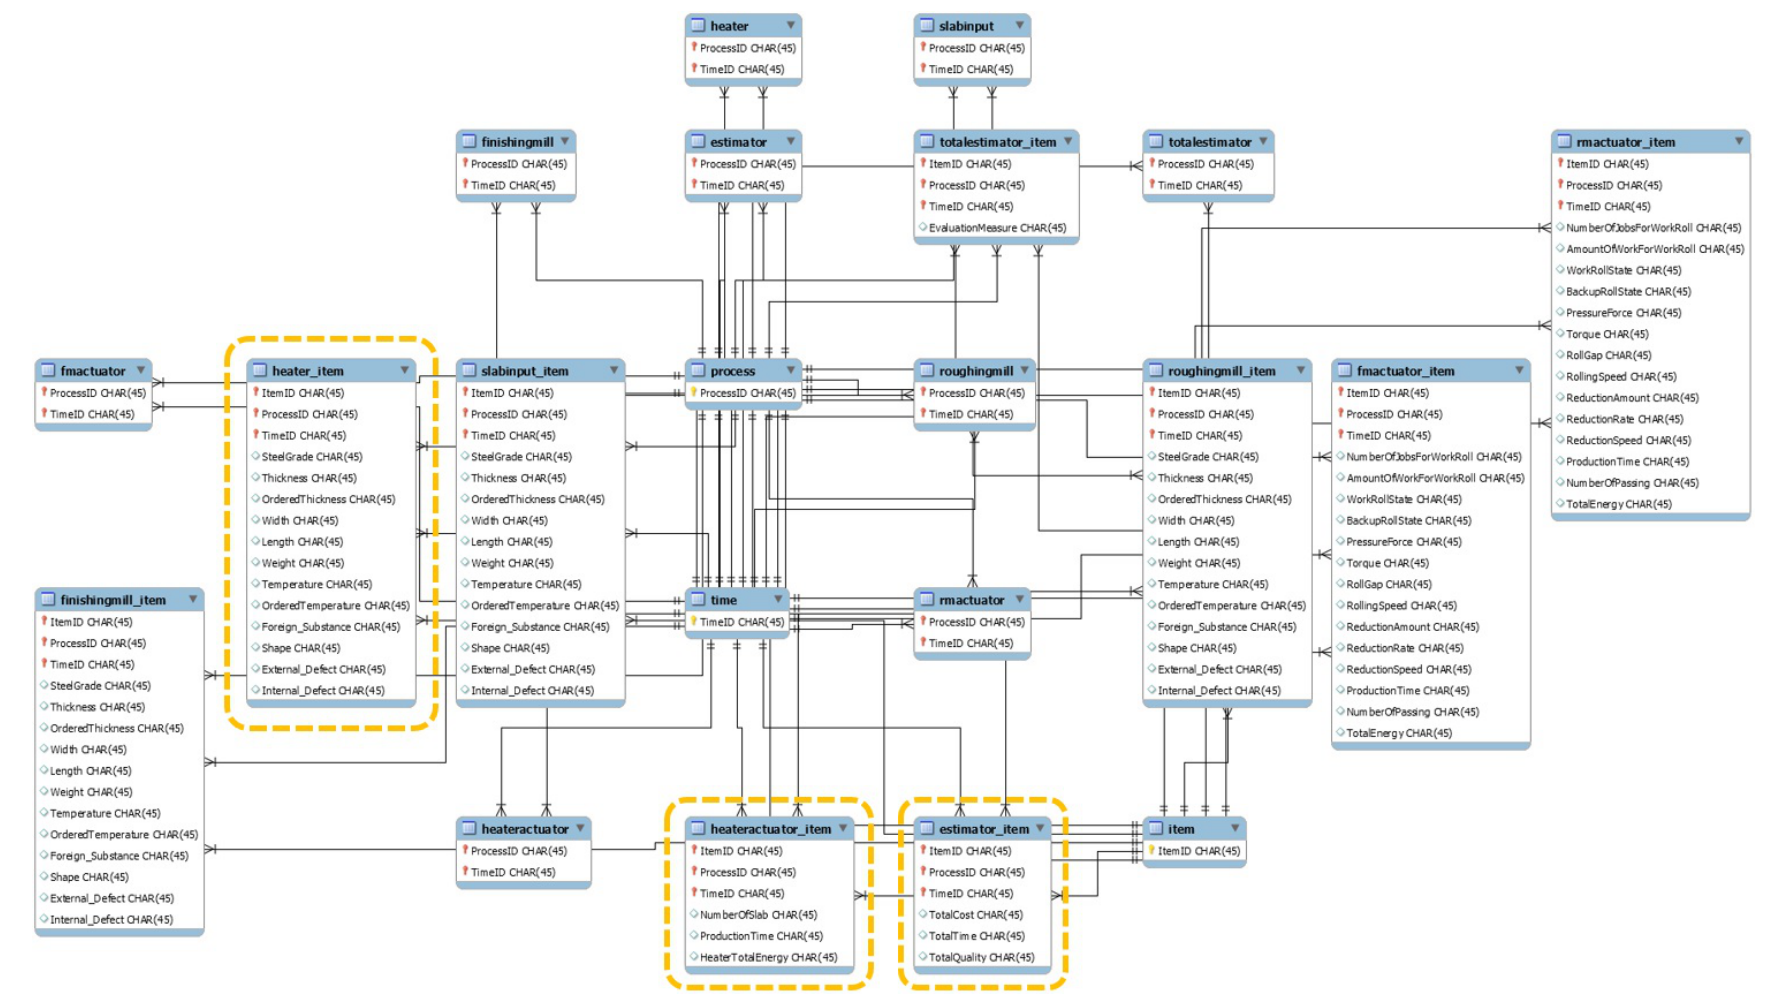
Figure 5. Partial MSAW Relational Database